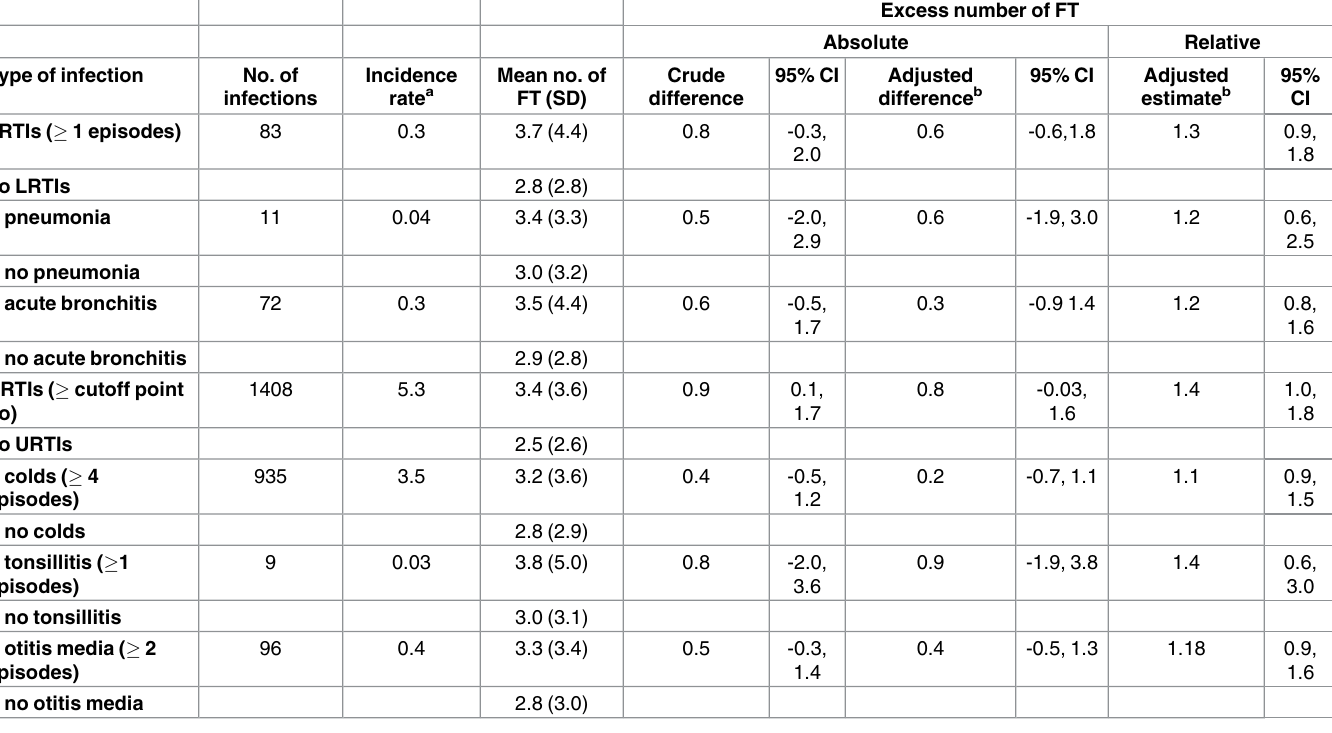
CI, confidence interval; FT, filled teeth; LRTI, lower respiratory tract infection; No, number; URTI, upper respiratory tract infection a Incidence rates per person-year are based on 1623 person-years.